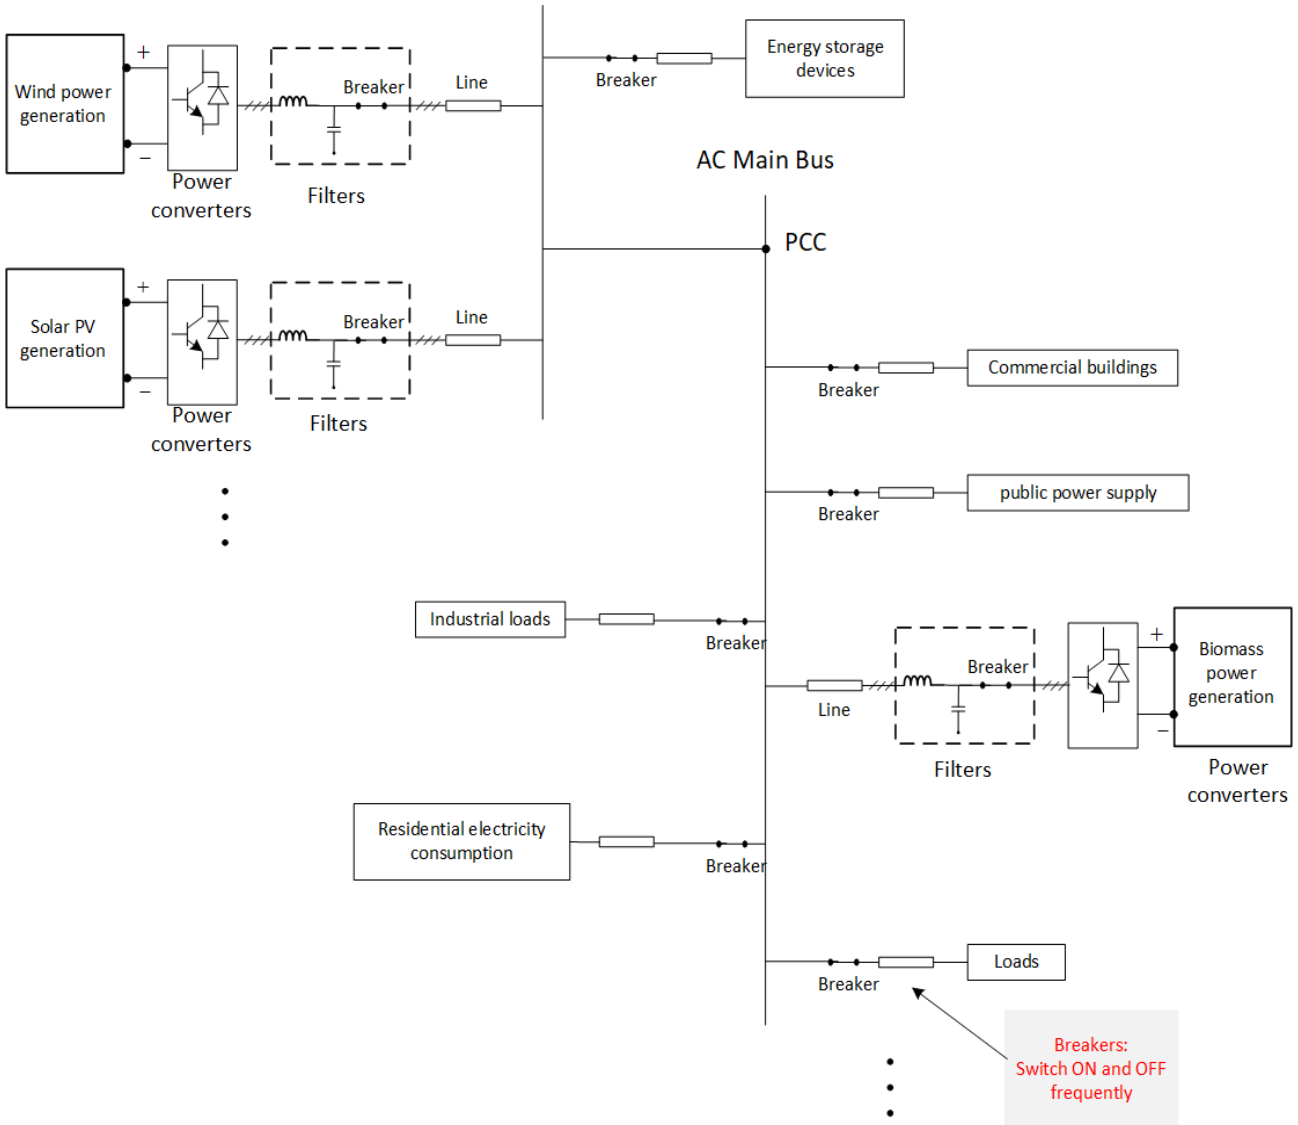
Figure 5. AC microgrid system structure.